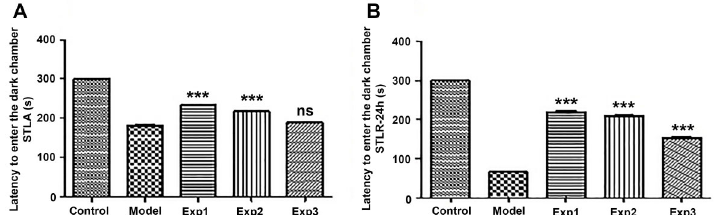
Figure 6. Effect of bilateral microinjection of insulin amyloid fi brils in the presence and absence of trans- chalcone. A , Step-through latency in the acquisition (STLA) trial in rats of the passive avoidance test. B , Step-through latency in the retention (STLR) test after 24 h of the passive avoidance test. Data are reported as means ± SE. ***P o 0.001 compared with model group (ANOVA). ns: not signi fi cant. See Table 1 for group